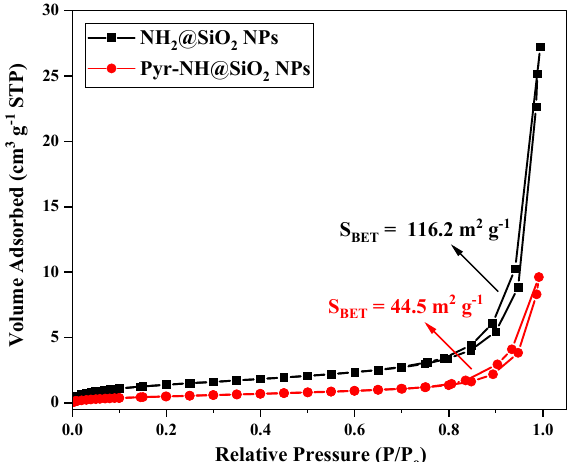
Table 1. Various parameters were obtained from N 2 adsorption-desorption isotherms, such as BET surface area (S BET ), total pore volume (V), and average pore diameter (D BJH ).